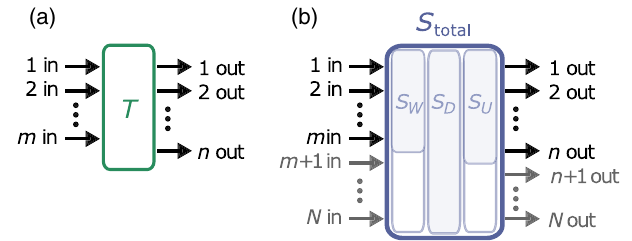
FIG. 1. The concept of mode transformations. (a) The linear network T specifies a mapping from m input modes to n output modes and may be characterized by a nonunitary matrix. (b) The full network S includes the nominal modes of T , as well as total ancilla modes, which account for any losses and gains in T . The transformation S consists of three main components, of which total only the second involves a coupling between the nominal modes and ancilla